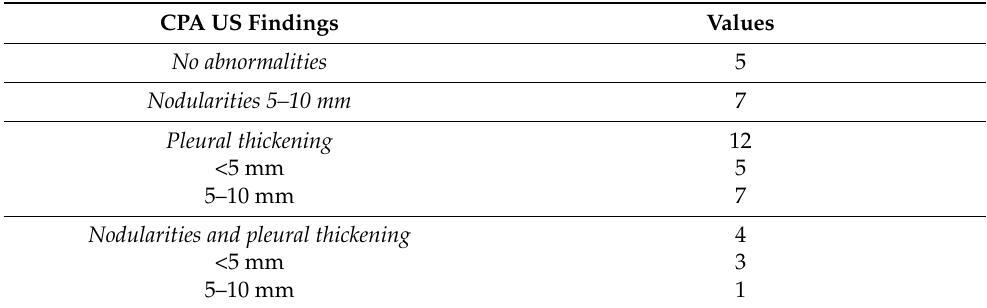
Figure 1. ( A ): Pleural nodularity; ( B ): Pleural thickening; ( C ): pattern of nodules and thickenings. Table 2. Chest US findings in CPA.